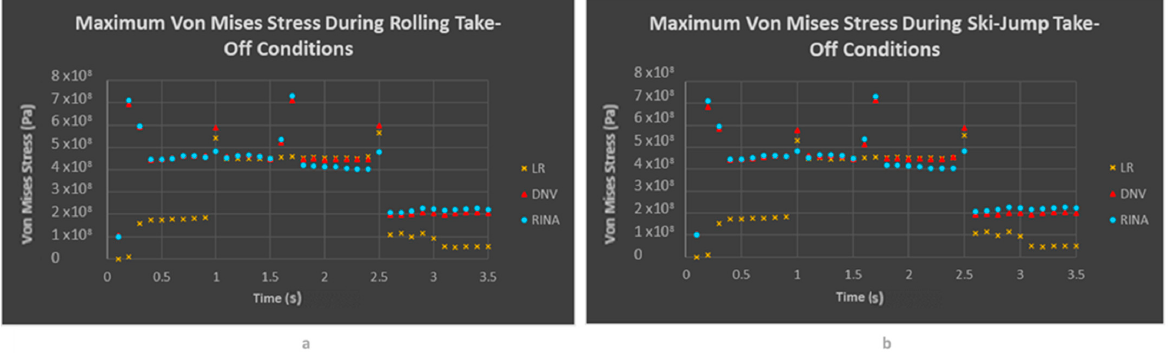
Figure 14. Maximum von Mises stress of the deck plate under the take-off condition; ( a ) dynamic take-off and ( b ) ski-jump.